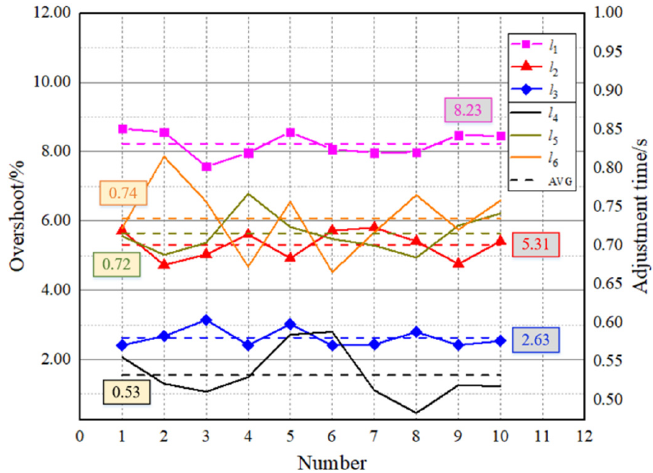
Figure 12. Change curve of overshoot and adjustment time of repeatability test during descending motion.